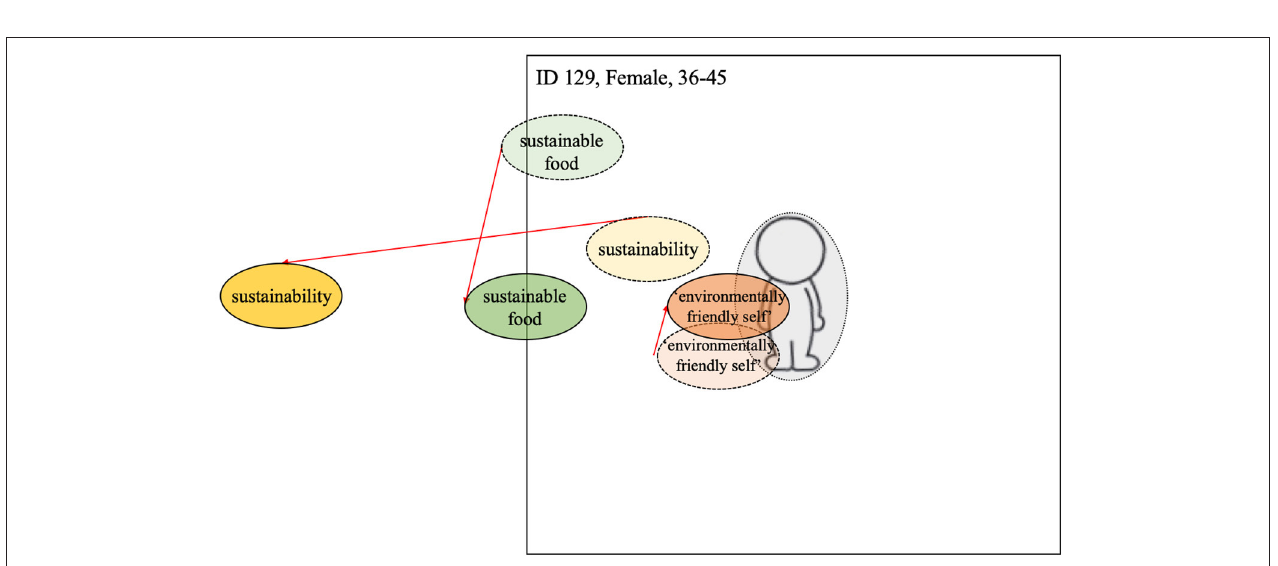
FIGURE 9 | Visualization of centrality of identity—Negative spillover. Dashed line = T1; solid line and darker coloring = T2; Red arrow indicates change from T1 to T2 (the colors were added after the analysis).